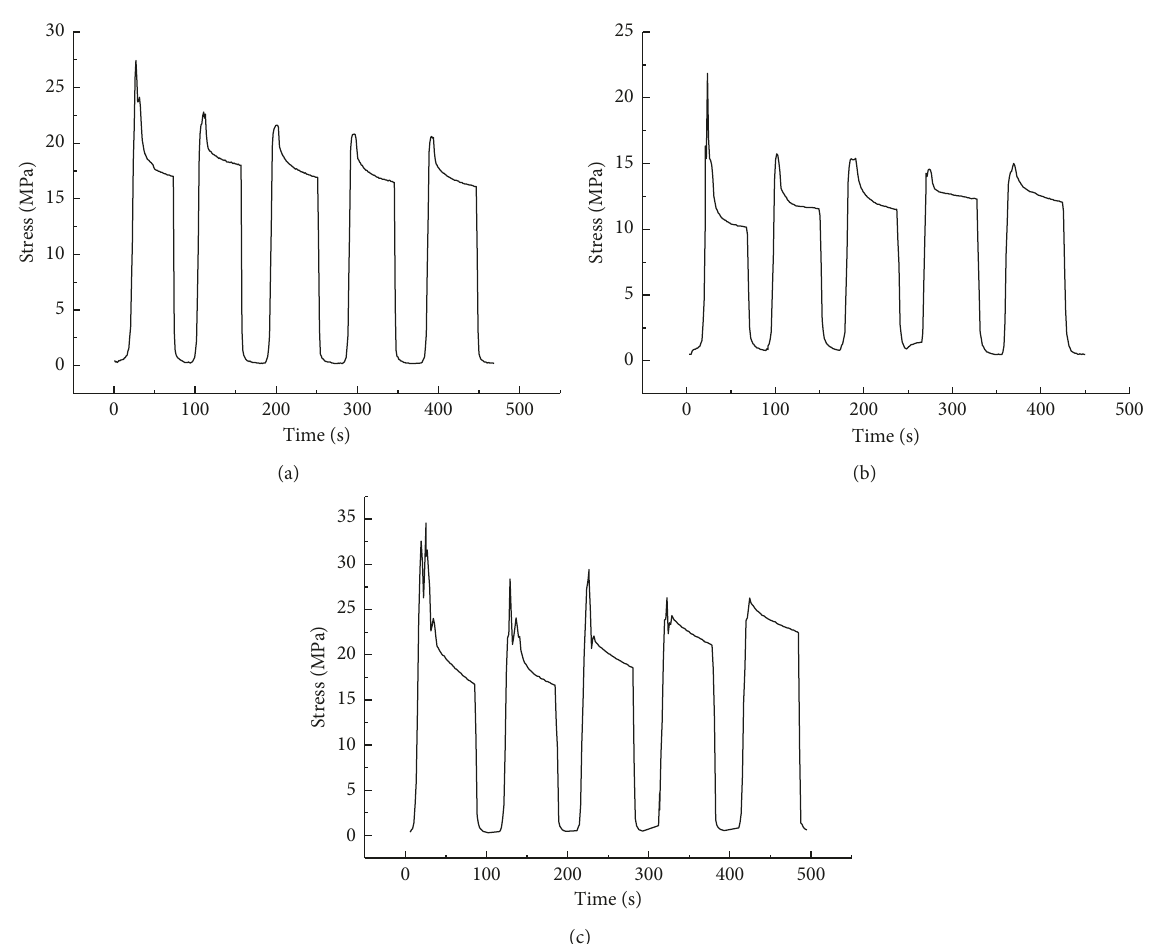
Figure 7: Hydraulic fracturing curves of the (a) first measuring point, (b) second measuring point, and (c) third measuring point.